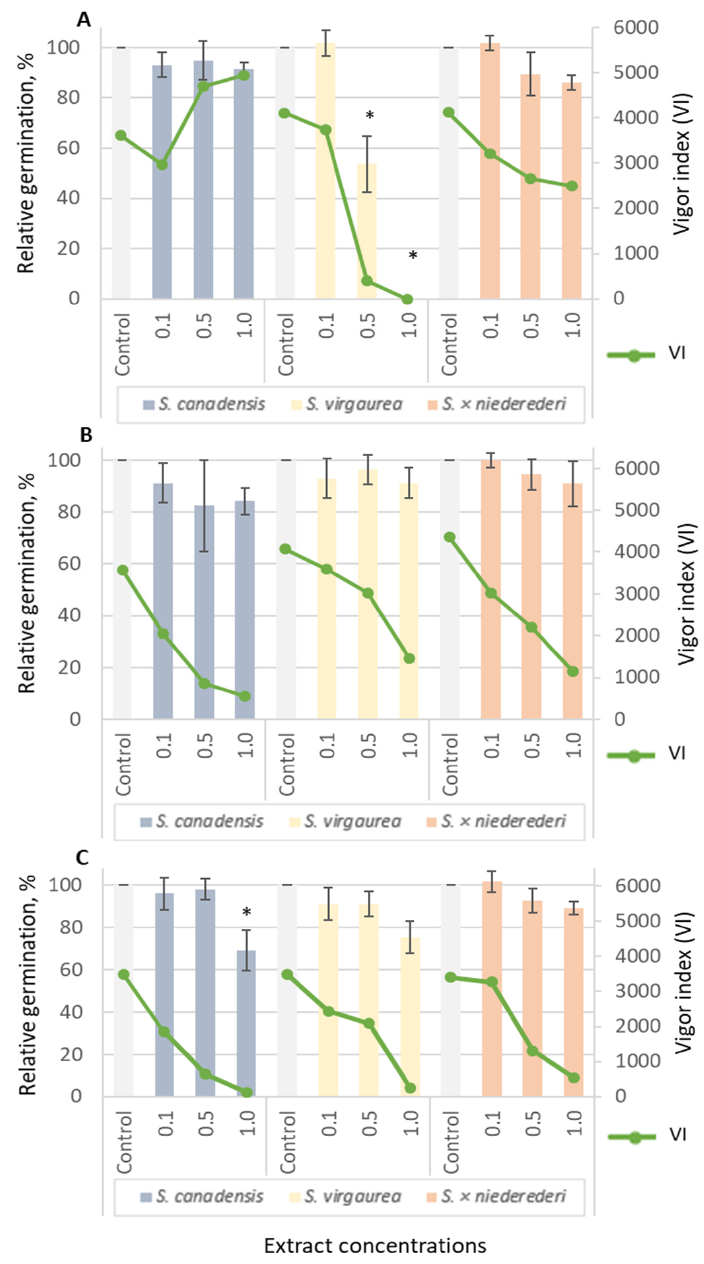
Figure 2. Inhibitory effect of aqueous extracts from S. canadensis , S. virgaurea and S. × niederederi roots ( A ), leaves ( B ) and inflorescences ( C ) on relative germination (RG) and vigor index (VI) of lettuce seeds (G test, p < 0.05). Data are presented as the mean of treatments (n = 60) ± SD (bars); asterisk (*) indicates a statistically significant difference compared to the control samples.